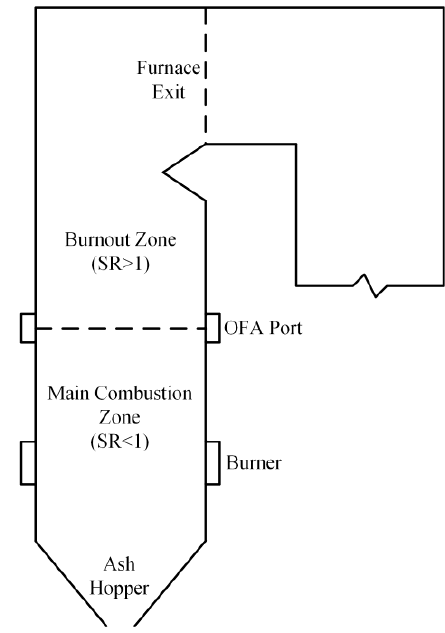
Figure 1. Pulverized coal boiler air-staged combustion NO x control system.